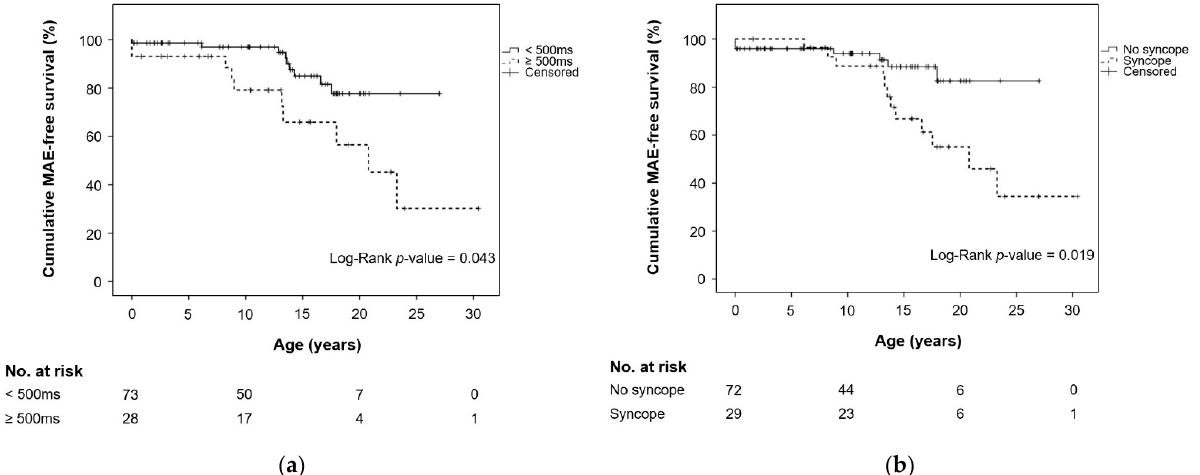
Figure 2. Kaplan–Meier estimates of survival without a major arrhythmic event (MAE) among the 101 patients with Long QT syndrome depending on ( a ) QTc value and ( b ) the occurrence of syncope. Patients with MAEs were more likely to carry a pathogenic variant in KCNH2 (13/40, 32.5%) or SCN5A (2/7 patients, 28.6%) than in KCNQ1 (3/54, 5.6%; p = 0.002) (Tables 1 and 2, Figure 3a). The probability of a cumulative MAE ‐ free survival was significantly lower if the patient carried the variant within the pore region (S5 ‐ loop ‐ S6 region) of the KCNH2 gene (Figure 3b and Figure 1).